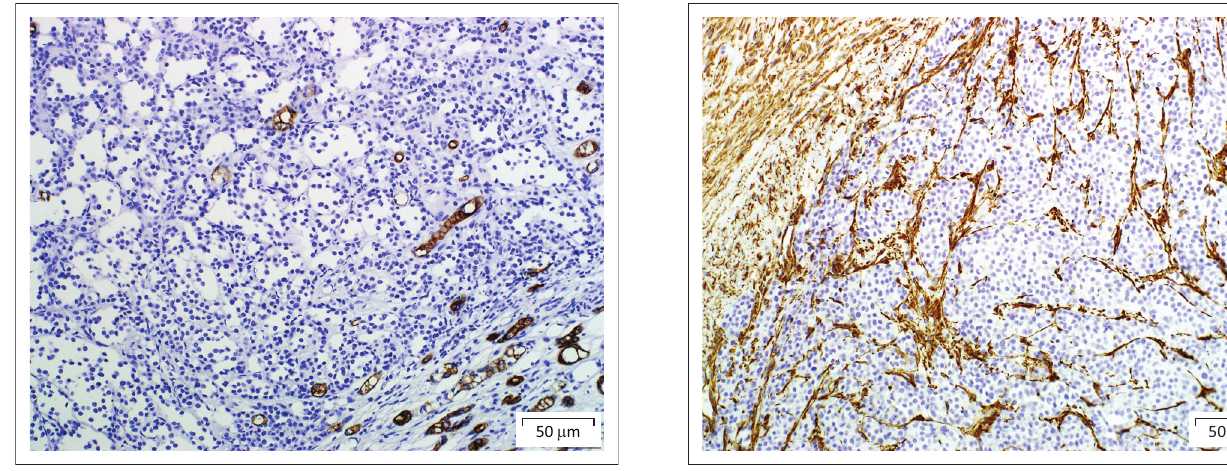
FIGURE 3: Renal paraganglioma. Neoplastic cells failed to label with the AE1/AE3 pan-cytokeratin antibody, but renal collecting tubules/ducts between the neoplastic cells labelled positive for pan-cytokeratin AE1/AE3 (which detects low- and high-molecular weight cytokeratins found in renal tubular and ductal epithelium and in urothelium).